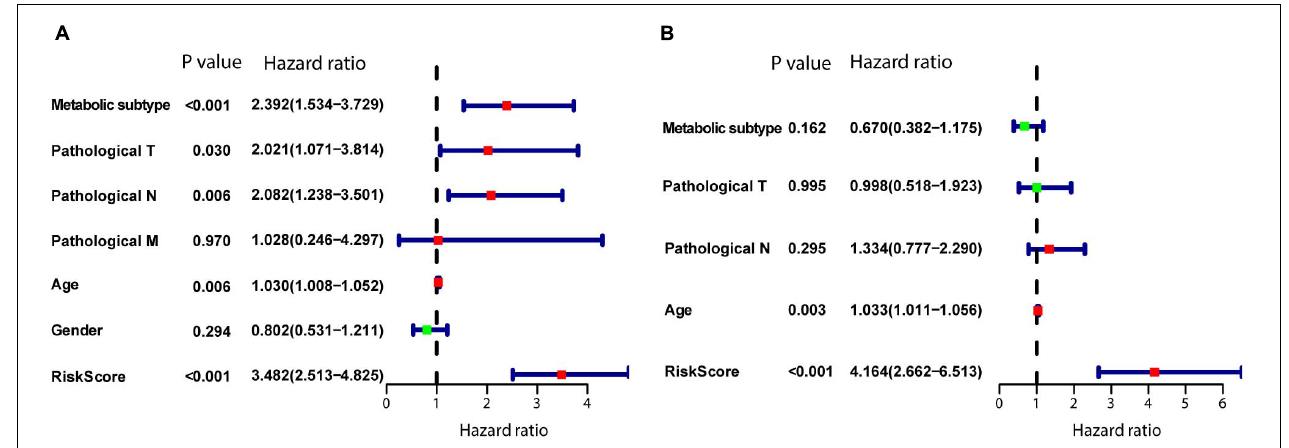
FIGURE 9 | Establishment of the model as an independent prognostic factor. (A) Univariate Cox regression. (B) Multivariate Cox regression. P < 0.05 was defined as statistically